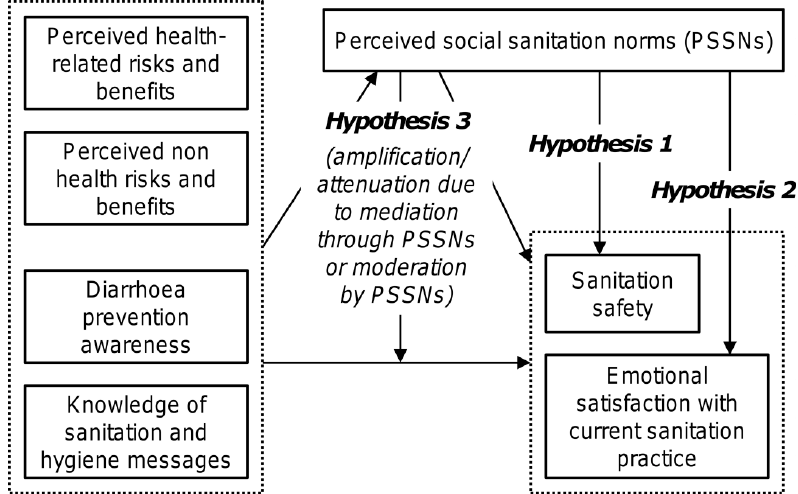
Figure 2. Hypotheses examined in this study (H1—direct effect of PSSNs on sanitation safety; H2—effect of perceived social sanitation norms (PSSNs) on emotional satisfaction; H3—PSSNs moderate or mediate effects of perceived risks and benefits and hygiene and sanitation awareness).